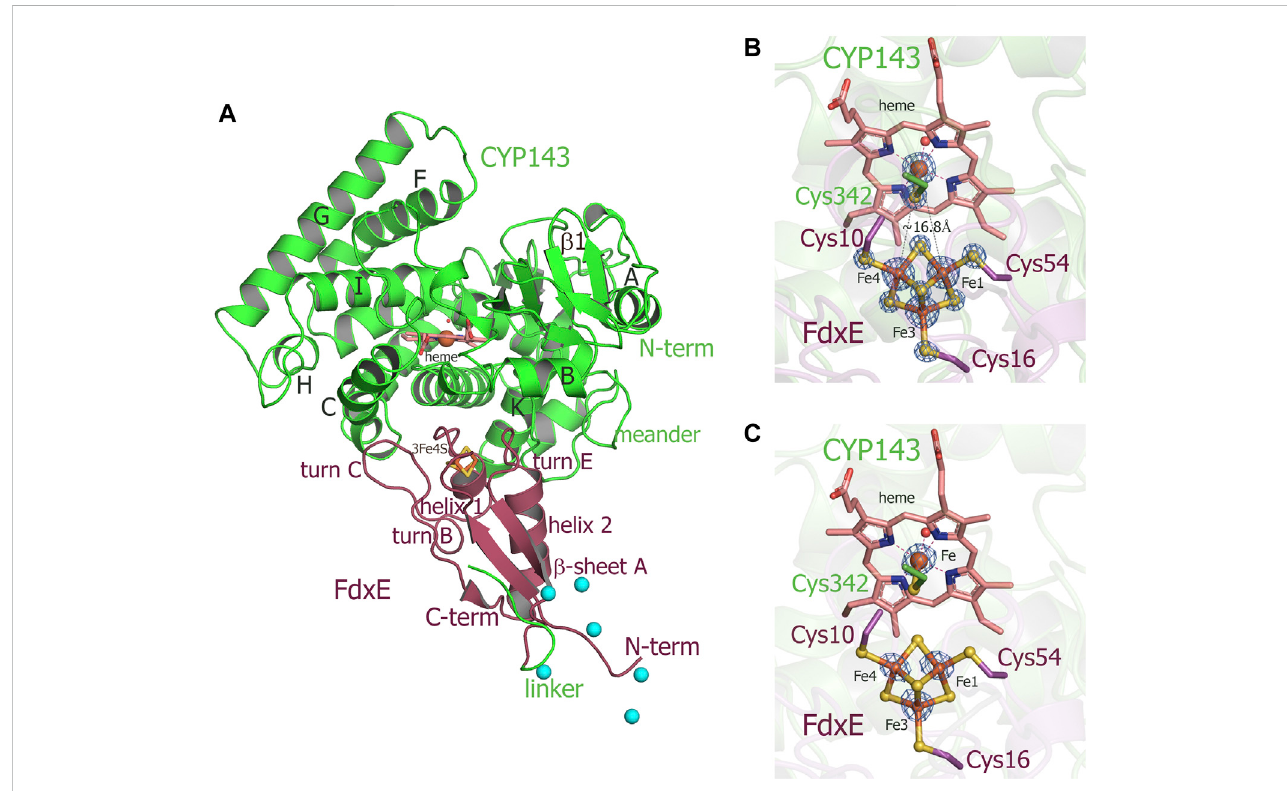
FIGURE 3 (A) Overall structure of the FdxE – CYP143 fusion protein. (B,C) Zoomed-in view of redox cofactors. (B) 2Fo-Fc maps are countered at 7 σ , donor – acceptor edge to the edge distance is shown as gray dashed lines. (C) Anomalous difference Fourier maps contoured at 4 σ . FdxE binds (raspberry) at theproximalfaceofCYP143(green).CyanspheresareNi ionsfromcrystallizationconditionsbound toHis-tag.TheN-termHis-tag